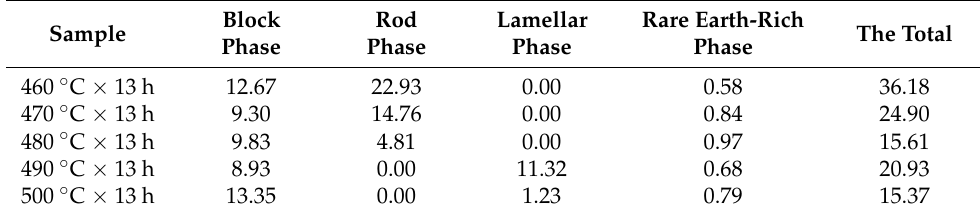
Figure 8. Statistical histogram of volume fraction of LPSO phase, rare earth-rich phase and total second phase. Table 2. Volume fraction statistics of block phase, rod phase, lamellar phase, rare earth-rich phase, and total second phase (%).